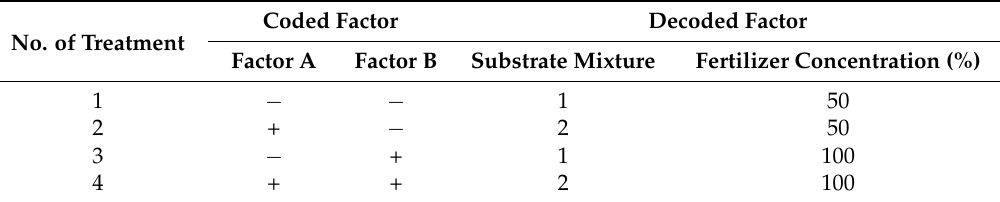
Table 5. Experimental design for evaluating substrate mixtures and fertilizer